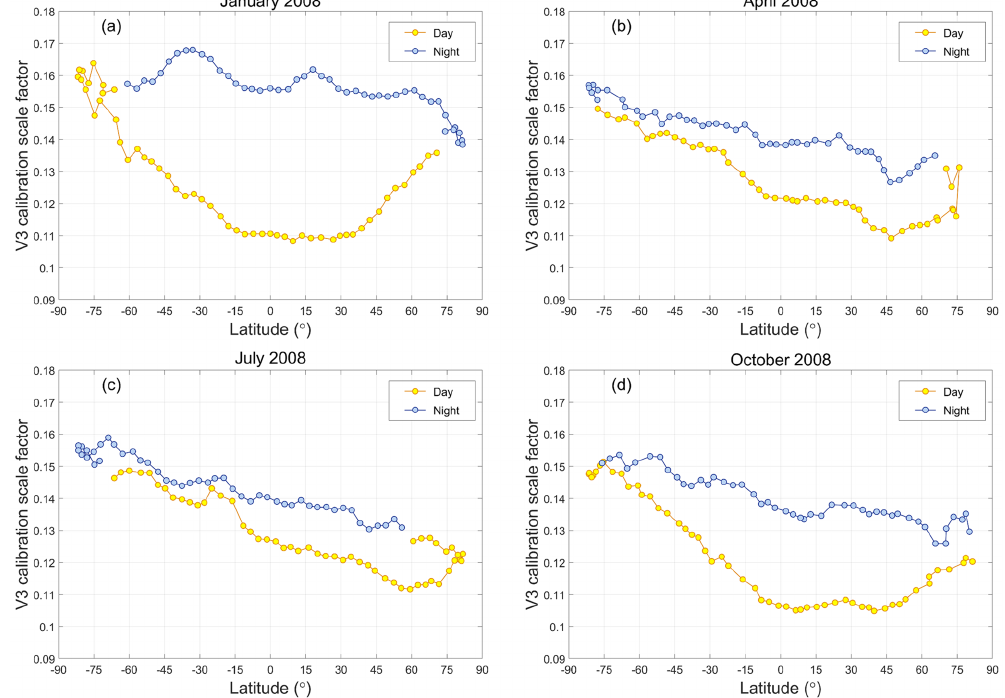
Figure 5. Monthly averages of daytime (yellow) and nighttime (blue) V3 calibration scale factors (i.e., F V3 ) as computed as functions of granule elapsed time and plotted as functions of latitude for (a) January, (b) April, (c) July, and (d) October 2008.